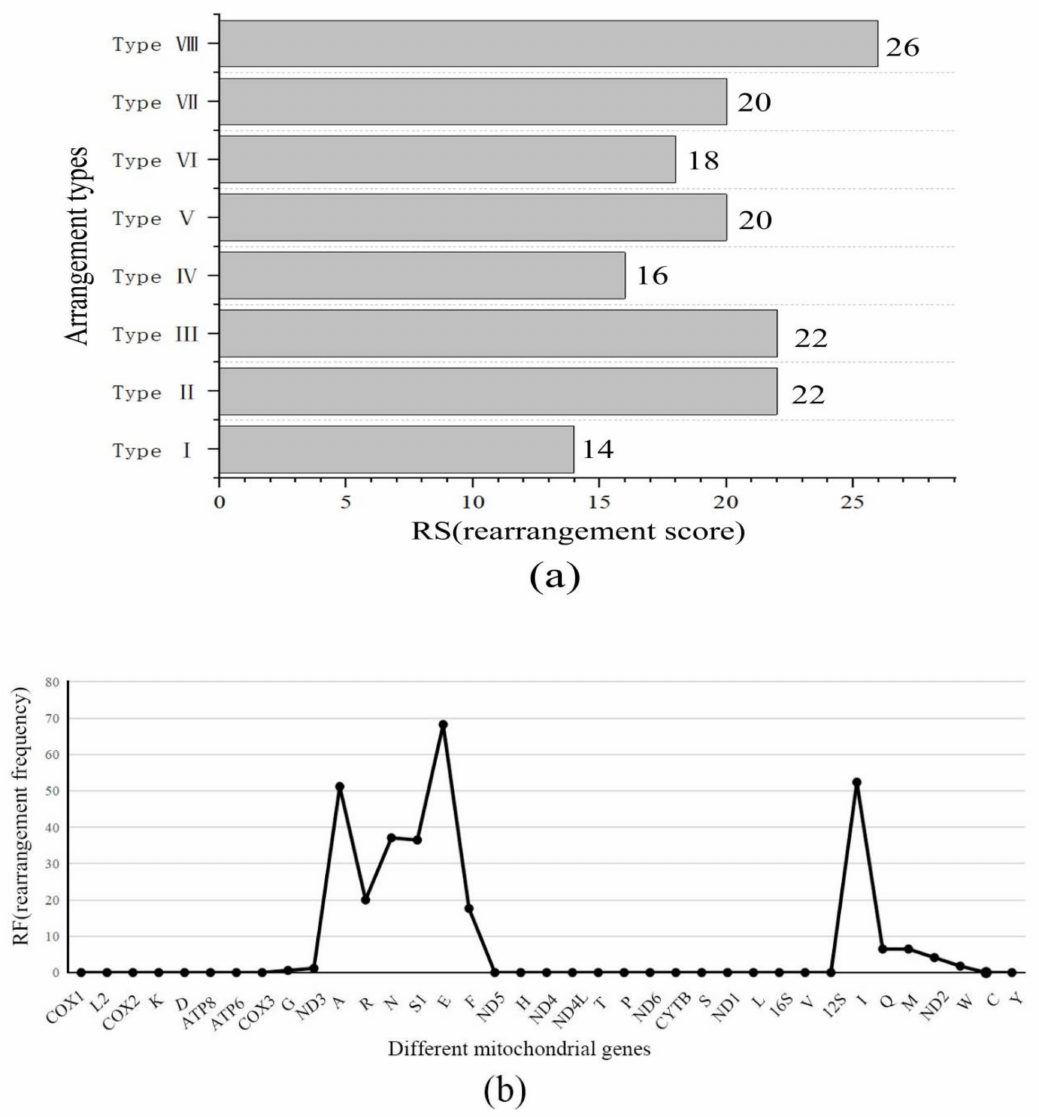
Figure 6. Distribution of rearrangement frequencies (RFs) and rearrangement scores (RSs) for the eight gene arrangement types in Ensifera, based on the application of qMGRs. ( a ) The RS of each arrangement type. ( b ) The RF of every single mitochondrial gene in all the analyzed